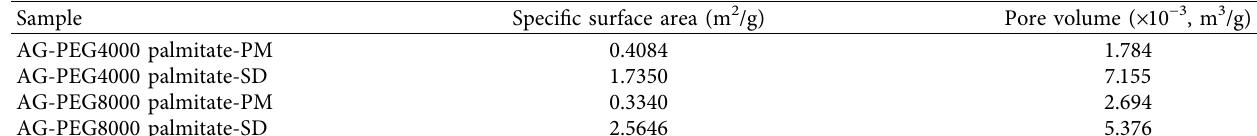
Figure 5: SEM photographs of (a) pure AG, (b) AG-PEG4000 palmitate-PM, (c) AG-PEG4000 palmitate-SD, (d) AG-PEG8000 palmitate- PM, and (e) AG-PEG8000 palmitate-SD. Table 2: Specific surface area and pore volume of physical mixtures (PM) and SDs.